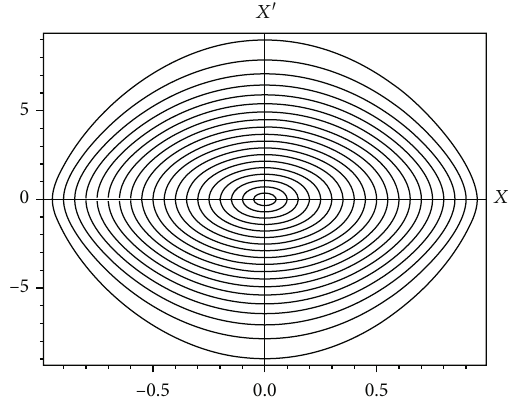
Figure 19: The central part of the phase portrait of the equation (38), where g ð x Þ = − 50 x + 25 x 3 .